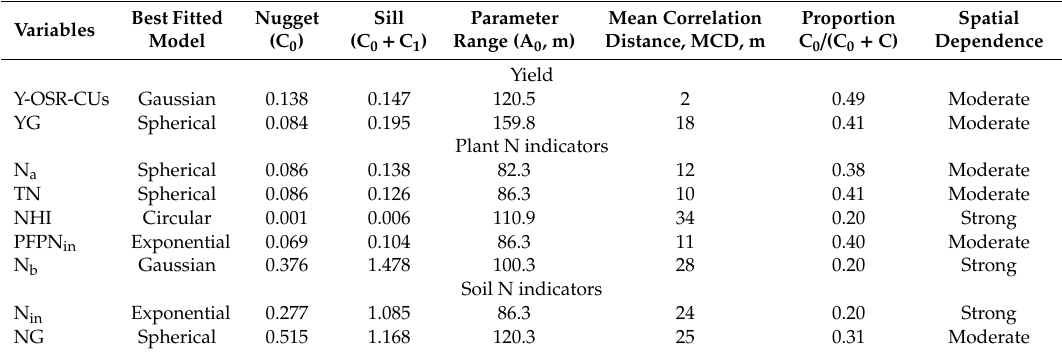
Table 5. Semivariogram parameters of yield and selected plant and soil nitrogen